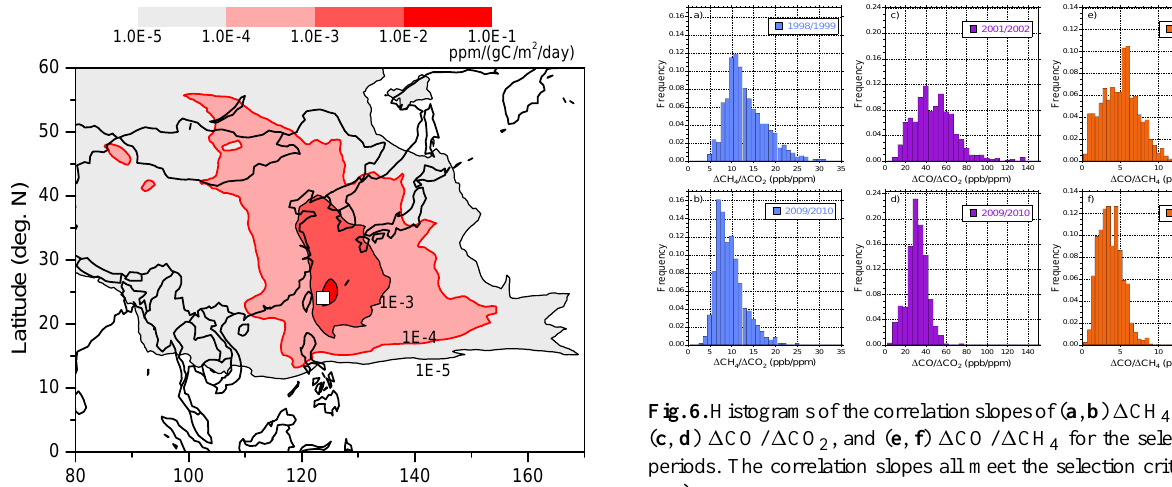
Fig. 6 (Tohjima et al.)